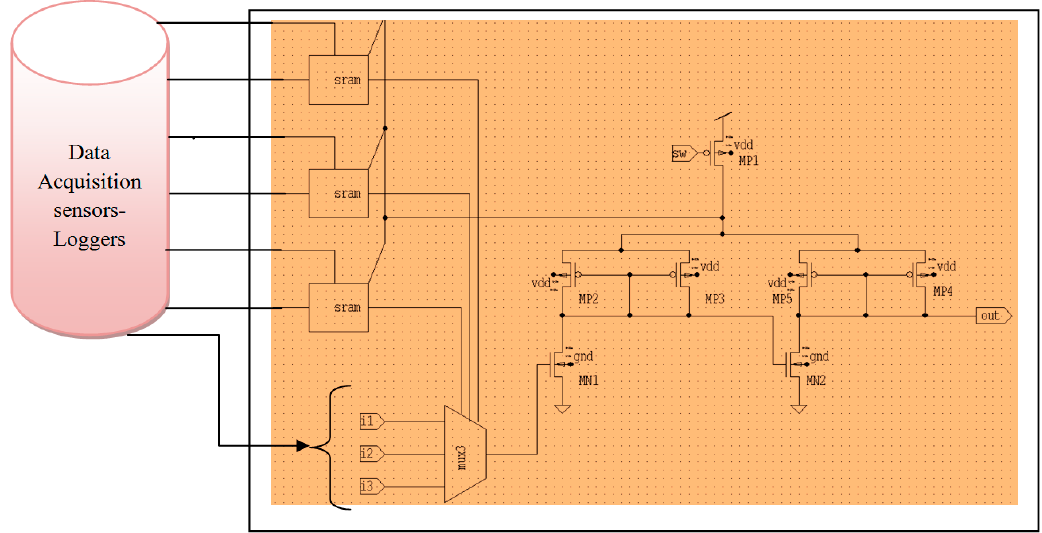
Figure 5. IoT data acquisition sensor architecture.